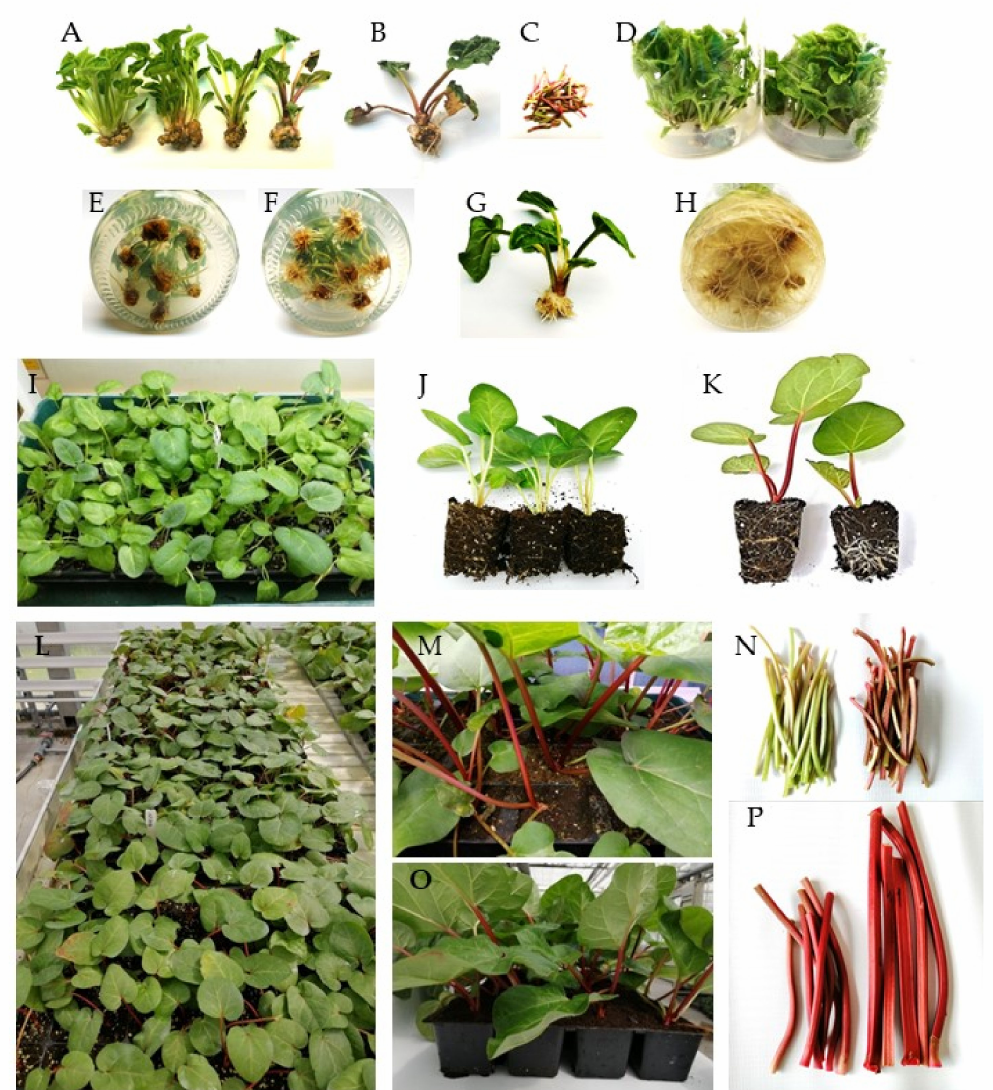
Figure 3. In vitro shoot formation, rooting and acclimatization of culinary rhubarb ‘Malinowy’. ( A ) Shoots multiplicated in mT medium containing different levels of sucrose (from the left: 59, 73, 88 and 175 mM); ( B ) shoots from BAP medium containing 175 mM sucrose; ( C ) leaf petioles from mT medium containing 175 mM sucrose; ( D ) shoot cultures; ( E ) roots three weeks after transfer to medium with 0.49 µ M IBA; ( F ) roots three weeks after transfer to medium with 4.9 µ M IBA; ( G ) shoots rooted in the presence of 4.9 µ M IBA; ( H ) roots after 4 weeks in medium with 4.9 µ M IBA; ( I – J ) plantlets four weeks after transfer to ex vitro conditions (growth room); ( K – L ) plantlets six weeks after transfer to the greenhouse; ( M – O ) plantlets nine weeks after transfer to the greenhouse; ( N – P ) leaf petioles after different periods of growing ex